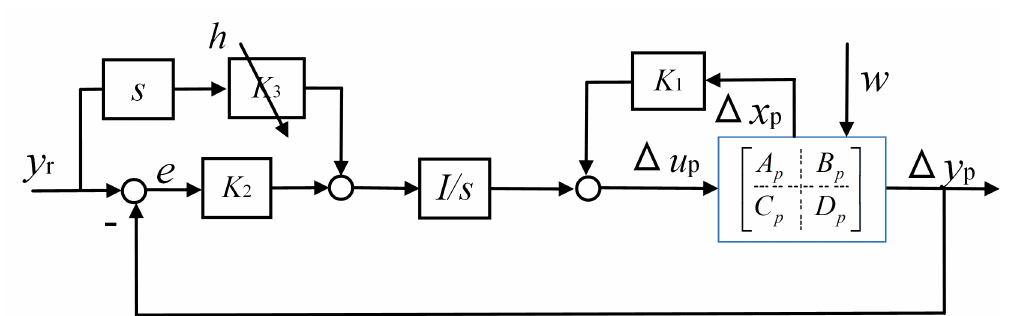
Figure 3. Diagram of output tracking control for a bounded